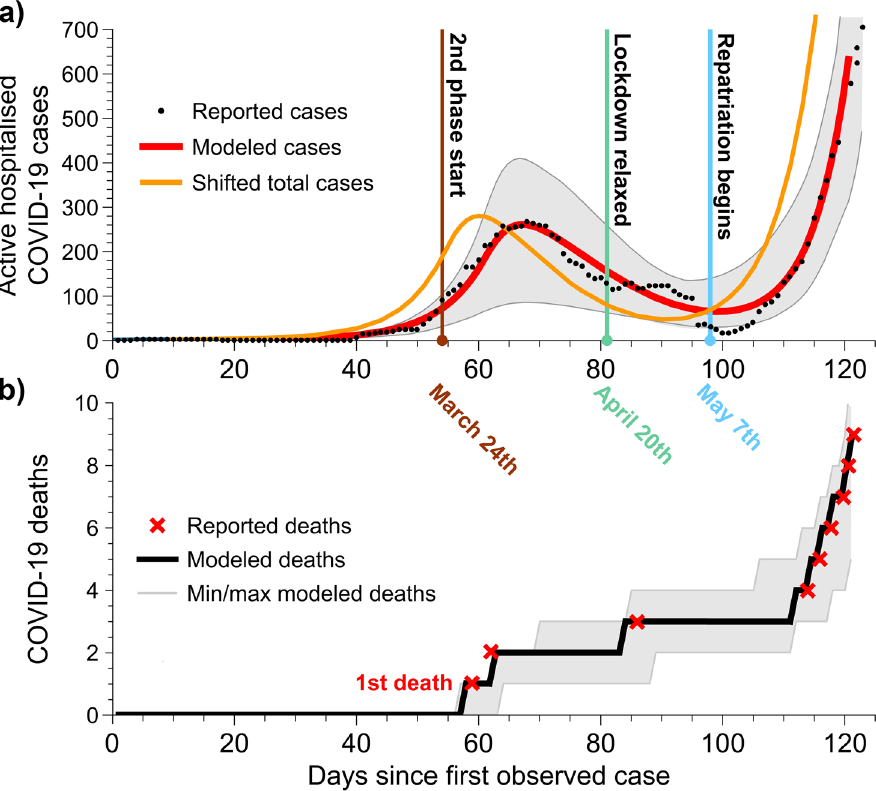
Figure 2. Observed and modelled COVID-19 cases in Kerala, from January 30th to May 30th 2020. ( a ) Modelled and reported active, hospitalised COVID-19 cases in the state. Also shown is the modelled total cases (in and out of hospital combined), shifted by 7 days, which is the number of days in the model between someone being suspected of having the disease and being officially reported. The minimum and maximum bounds of the modelled reported hospital cases from the MCMC fitting are included in grey. ( b ) Modelled and observed cumulative deaths due to COVID-19 in Kerala. Minimum and maximum bounds from the MCMC fitting are shown in